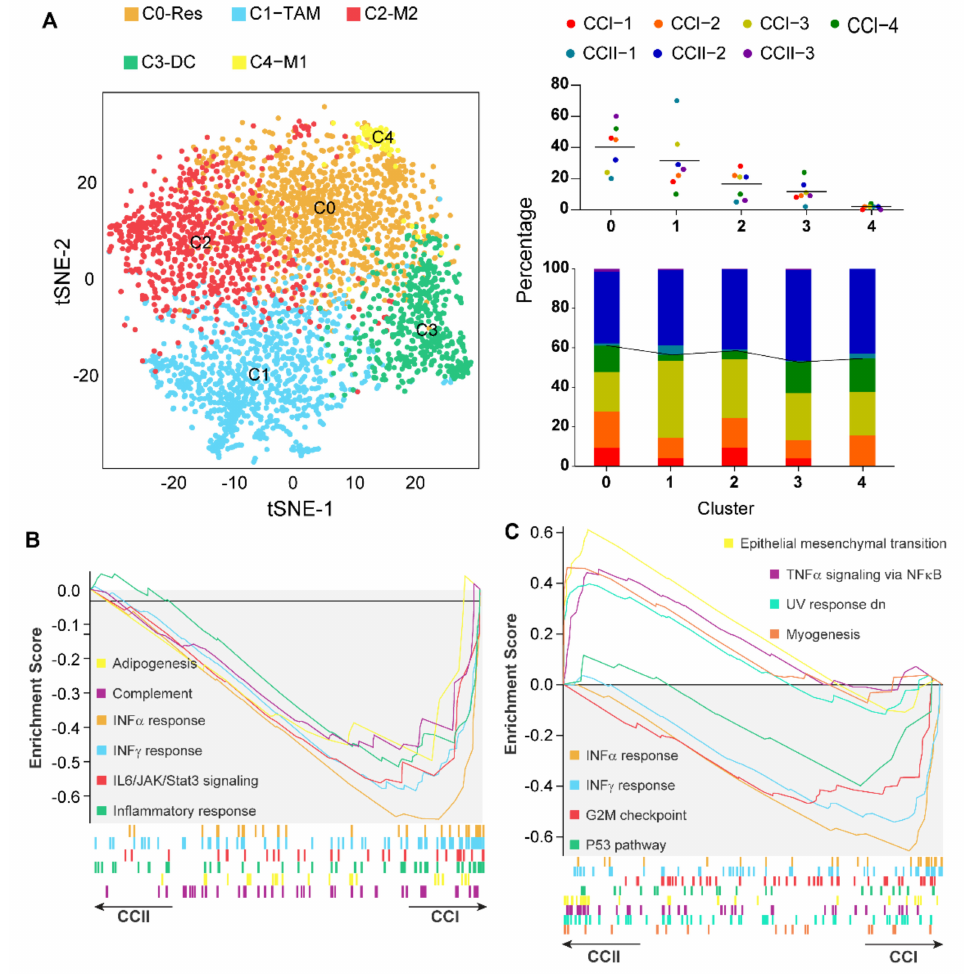
Figure 6. Comparative analysis of the functions of macrophages in the TME of early (CCI) and late (CCII) stage cervical cancer patients. ( A ) 2D t-SNE distribution of macrophage subtypes identified, including resident-like, TAM, M2-like, M Φ /DC, and M1-like M Φ s ( left ). Proportions of each M Φ subpopulation in the M Φ s of the patients ( top right ) and the proportion of individual patient M Φ in each subpopulation ( bottom right ). GSEA analysis of the enriched Hallmark pathways in M1-like M Φ s ( B ) and TAMs ( C